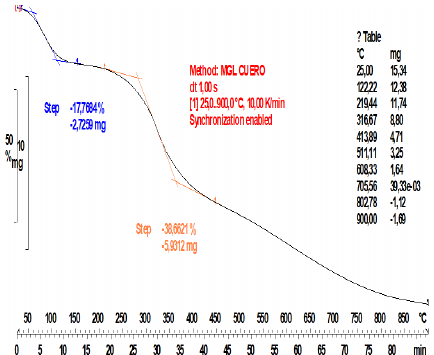
Figure 2. Thermogravimetric analysis of chromium-free tanned leather.